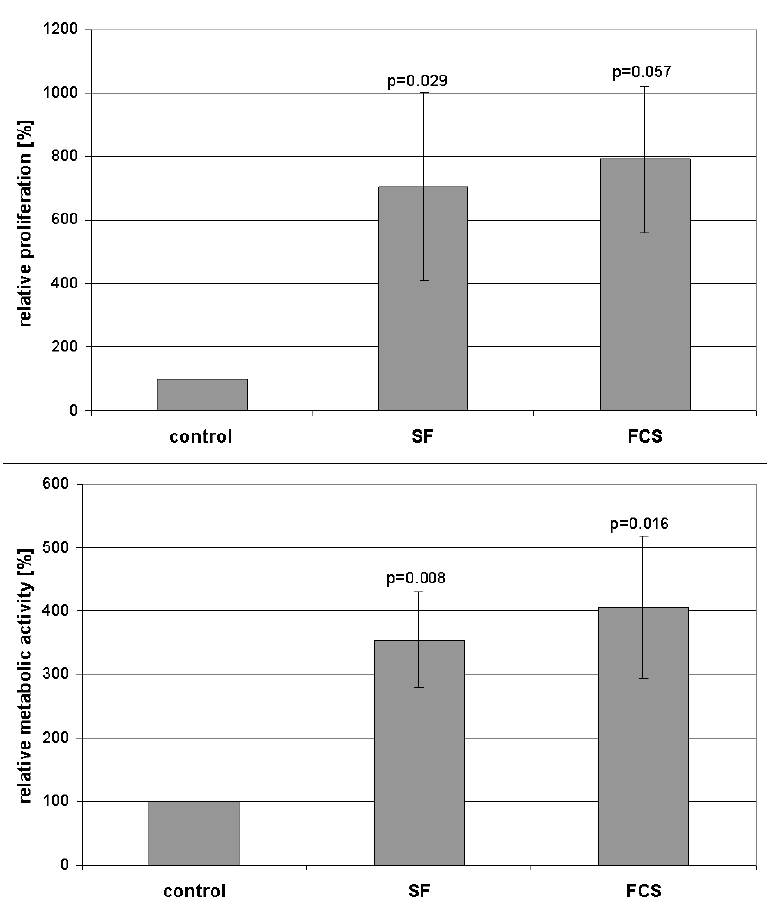
FIGURE 1. Mitogenic and metabolic activity SF on osteoblasts. Osteoblasts were seeded in a 96 well plate at a density of 5000 cells/well and exposed for 48 h to SF or FCS (40 µl/200 µl). The proliferation rate was determined with BrdU (top) and the metabolic activity with MTT assay (bottom) as described under Materials and Methods. Data represent mean ± SD from four independent determinations done in